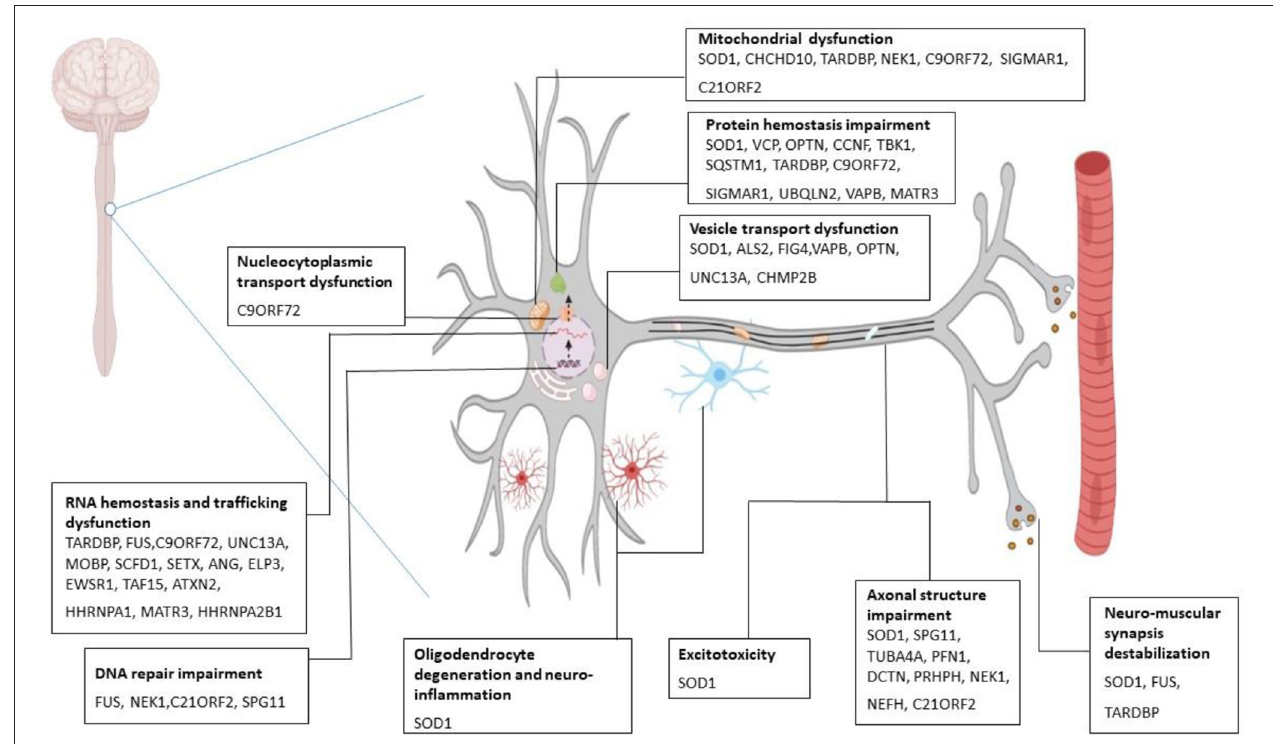
FIGURE 1 | Molecular mechanism of ALS pathogenesis. Several gene mutations are discovered to be associated with amyotrophic lateral sclerosis (ALS). Mutant SOD1 leads to cytoplasmic inclusions, chaperone dysregulation, and reduction in components of ubiquitin-proteasome system, oxidative stress, incorrect protein imports, and mitochondrial dysfunction. Mutant C9ORF79 causes the formation of RNA foci that can sequester RNA binding proteins and impair the translational process. Also, it produces dipeptide repeat proteins and causes neurotoxicity. Mutation in TARDBP (the gene which encodes TDP-43) gives rise to toxic aggregation of TDP-43 and impairs endosomal trafficking and mitochondrial function. FUS mutation perturbs DNA repair, RNA metabolism, and synaptic function (21–30). SOD1, superoxide dismutase; FUS, fused in sarcoma; TARDBP, transactive response DNA binding protein